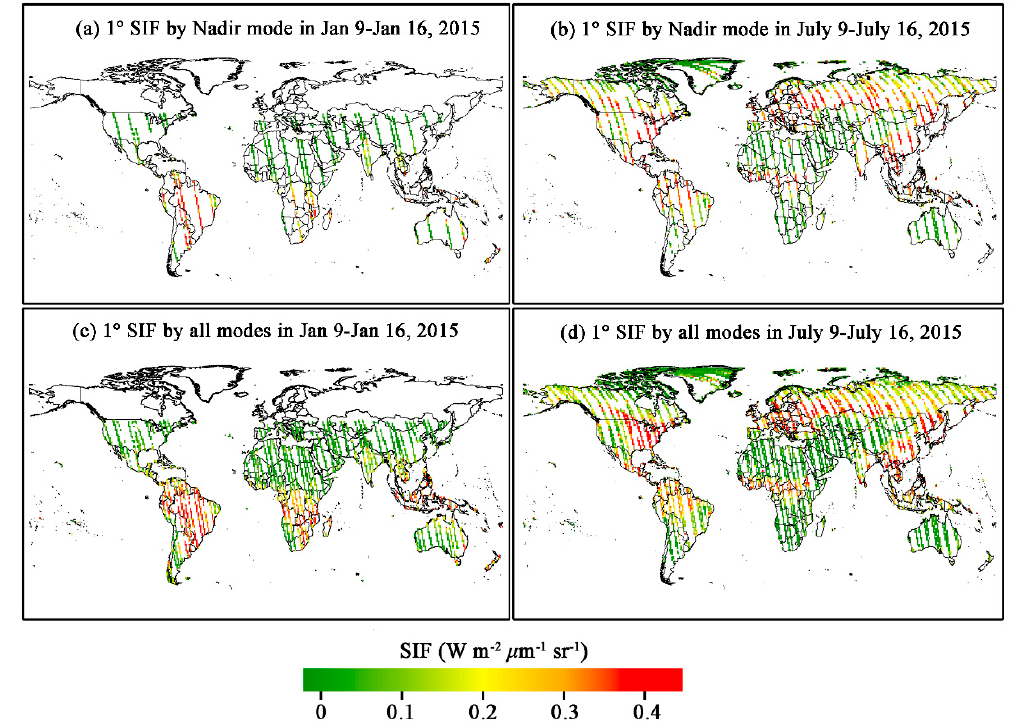
Figure 1. Examples of producing 1 ° , 8-day solar-induced chlorophyll fluorescence (SIF) maps from Orbiting Carbon Observatory-2 (OCO-2) soundings: ( a ) By Nadir mode in January 9–16, 2015; ( b ) by all modes in January 9–16, 2015; ( c ) by Nadir mode in July 9–16, 2015; and ( d ) by all modes in July 9–16, 2015.